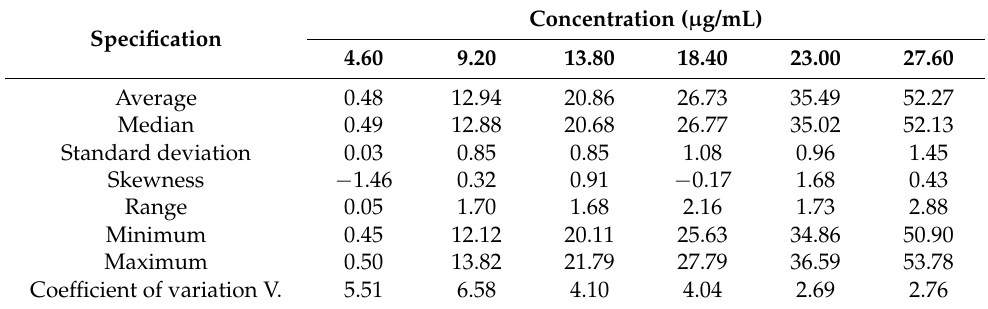
Table 9. DPPH radical scavenging activity of standard solution (Vitamin E) (experiment with the aerial part of the plant).